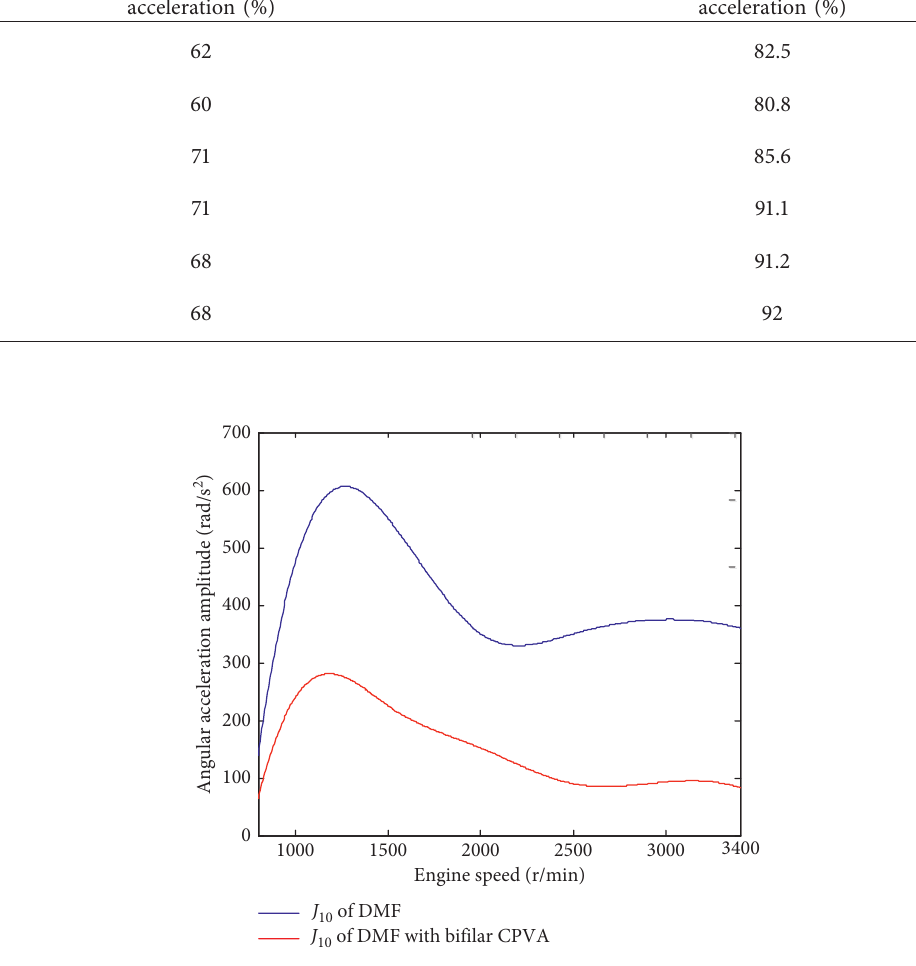
10 in the input shaft of the gearbox in the